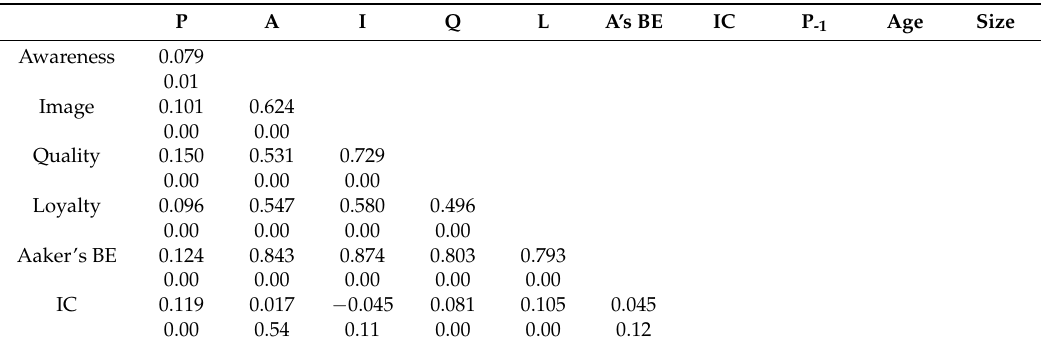
Table 3. Correlation